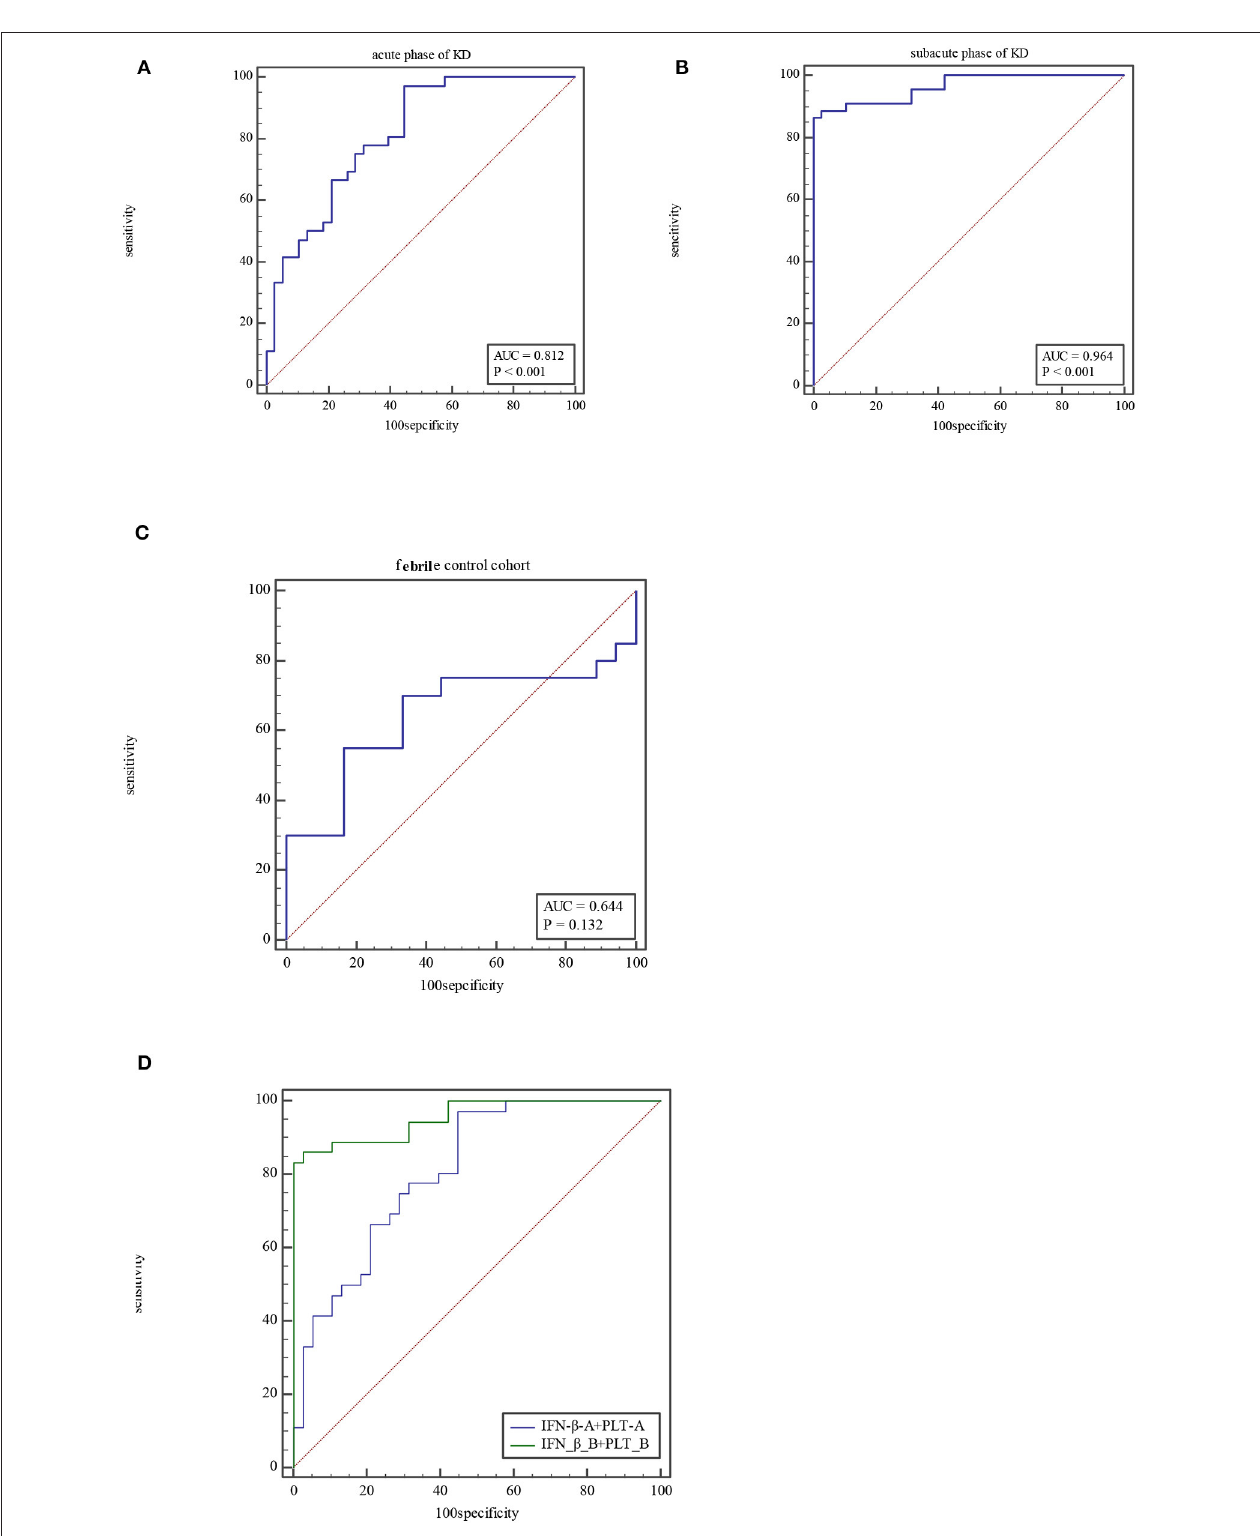
FIGURE 3 | ROC for combined IFN- β and PLT detection at acute phase of KD (A) , subacute phase of KD (B) , and febrile control corhort (C) . Comparison of ROC for combined IFN- β and PLT detection between at acute phase of KD and subacute phase (D) .